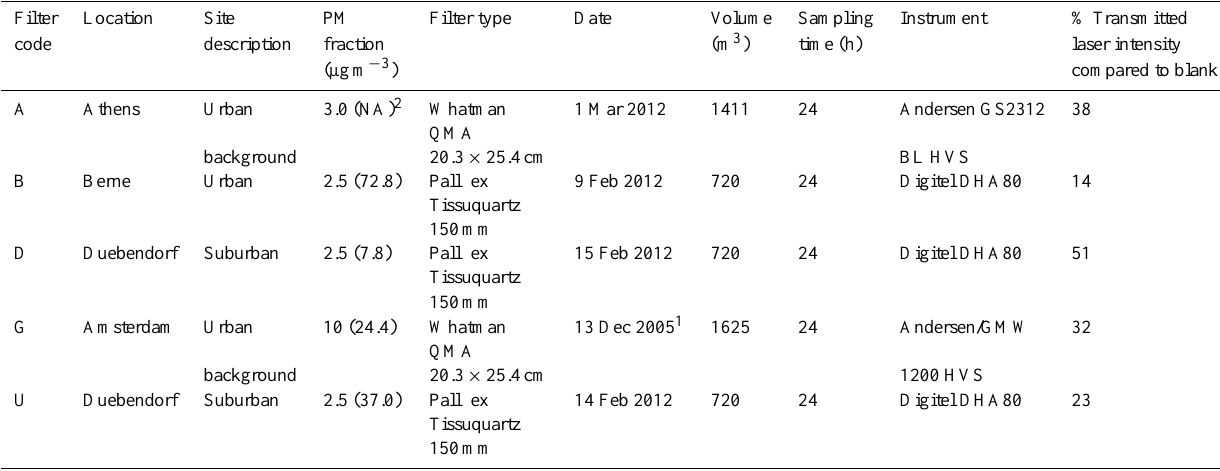
Table 1. PM loaded filters description and sampling details.